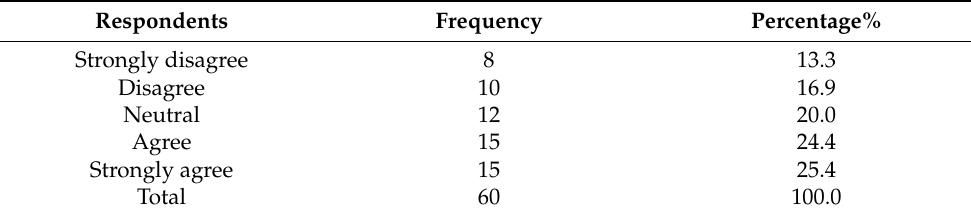
Table 12. The organization has implemented employee training and development initiatives.